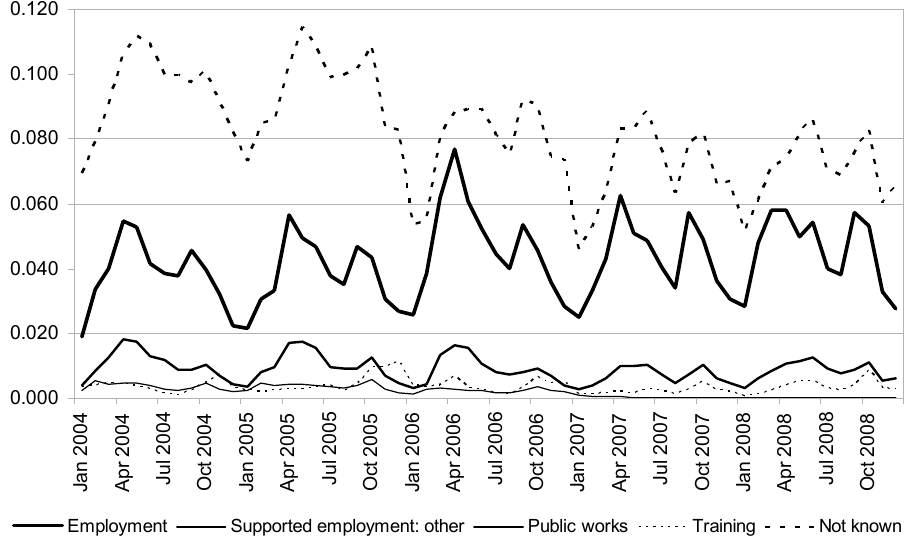
Figure 1: Monthly exit rates between 2004 and